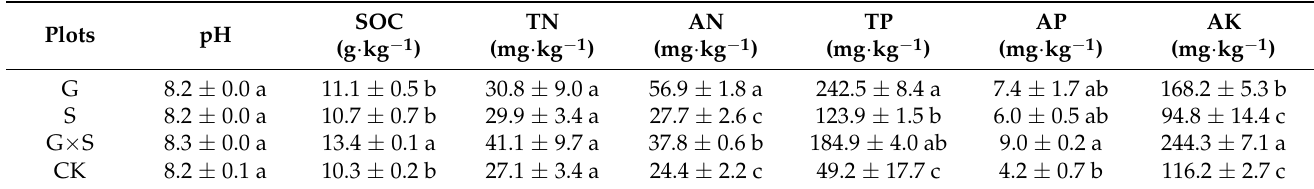
G represents grass, S represents shrubs, G × S represents grasses-shrubs, and CK represents bare soil without plants. Different lowercase letters indicate significant differences between treatments in the same column ( p < 0.05). Values are mean ± standard error (SE) ( n = 5). The same below.